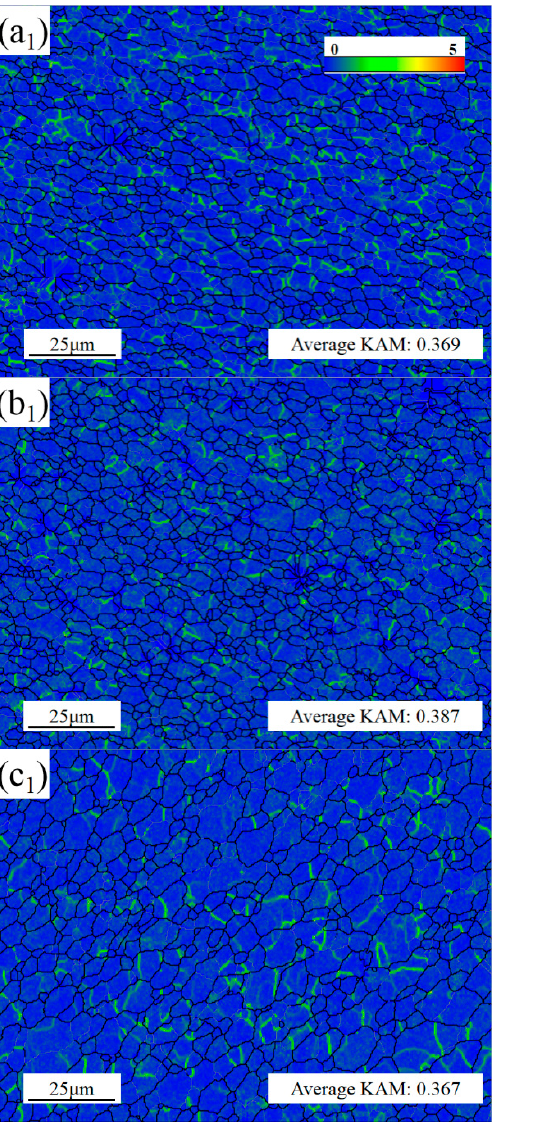
Figure 9. KAM and GROD angle maps of ( a1 , a2 ) SZ-1; ( b1 , b2 ) SZ-2 and ( c1 , c2 ) SZ-3.